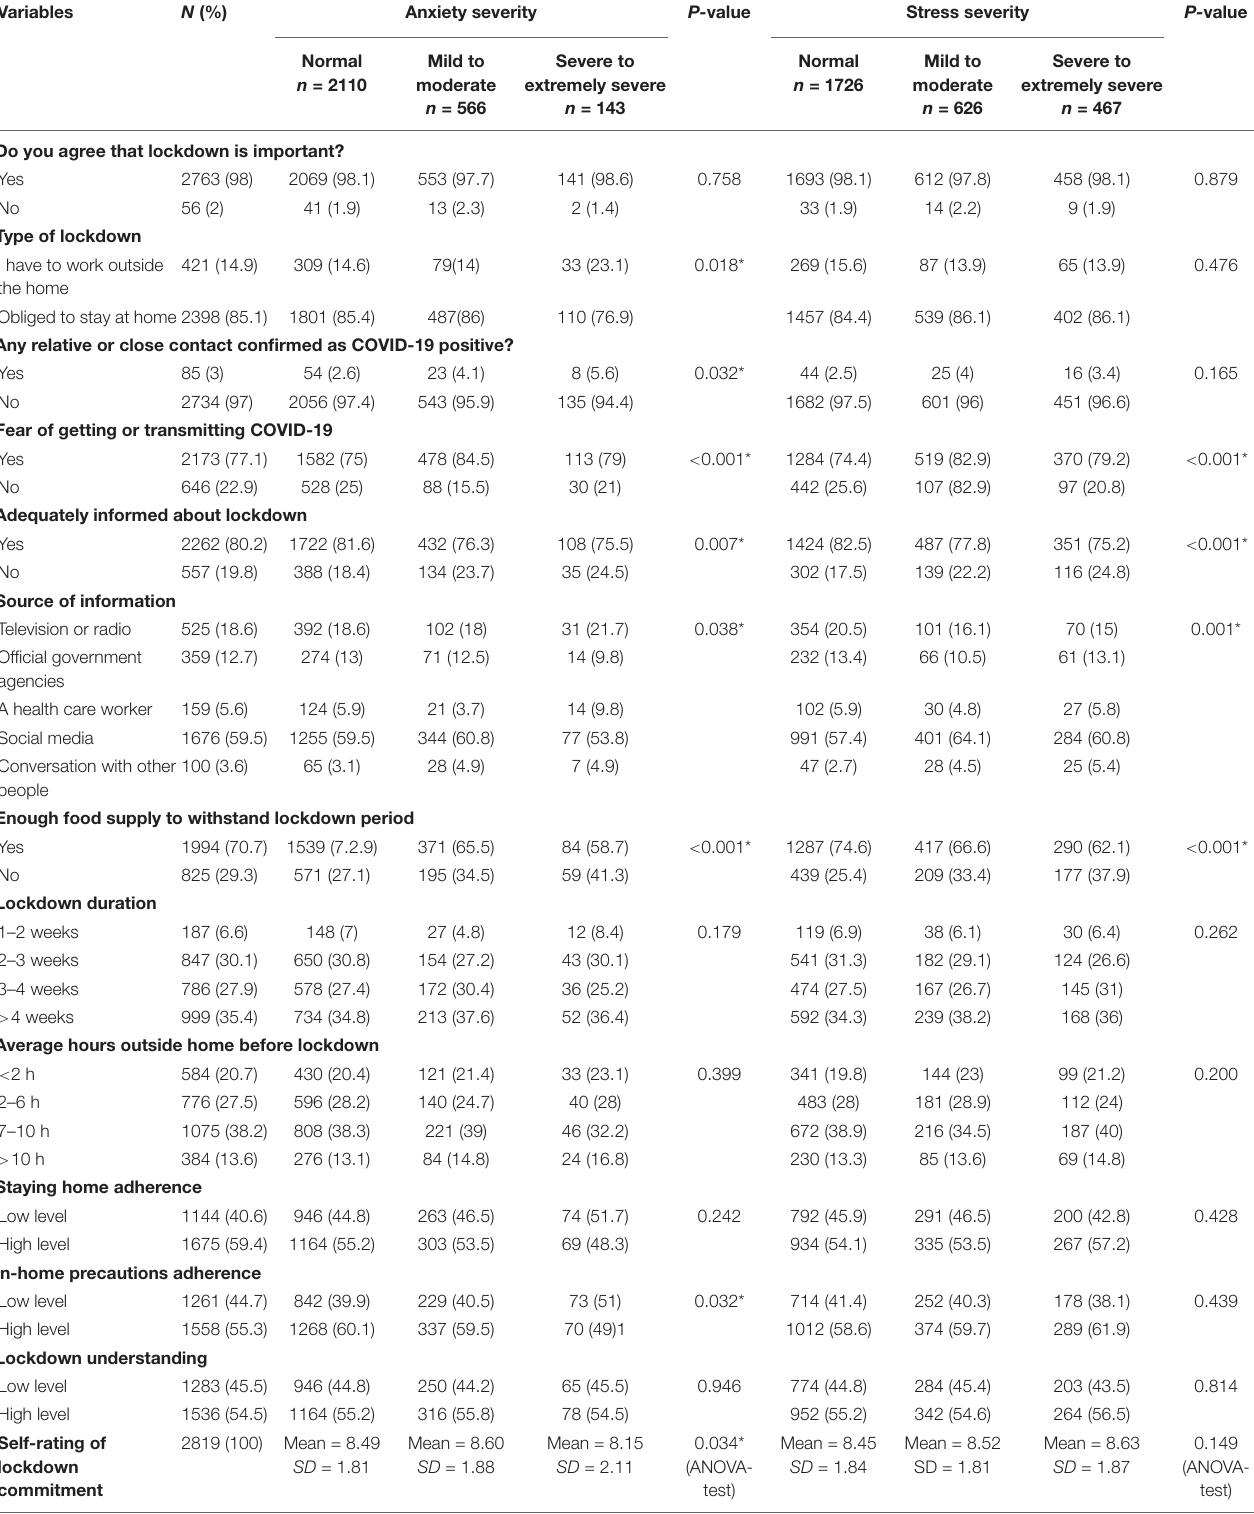
TABLE 2 | Bivariate analysis of lockdown characteristics with anxiety and stress severity ( P -value presented was Chi-square significance; N = 2819). Variables N (%) Anxiety severity P- value Stress severity P- value